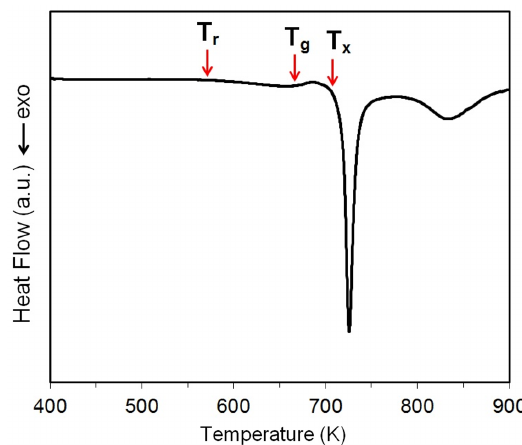
Figure 1. XRD patterns of the melt-spun Ag where x = 10, 15 and 20.